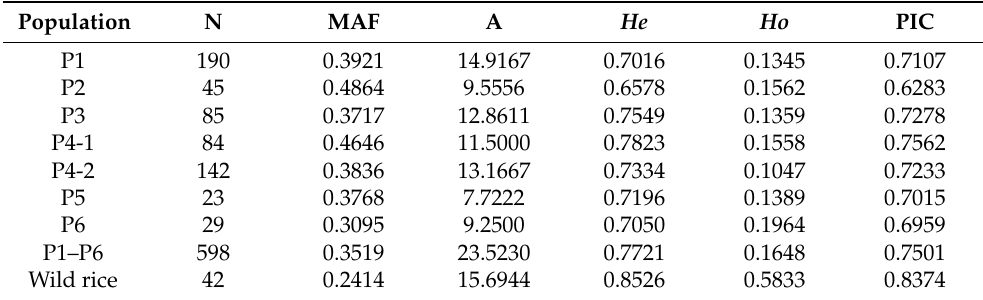
Table 3. Summary statistics for the genetic diversity of 640 rice accessions.